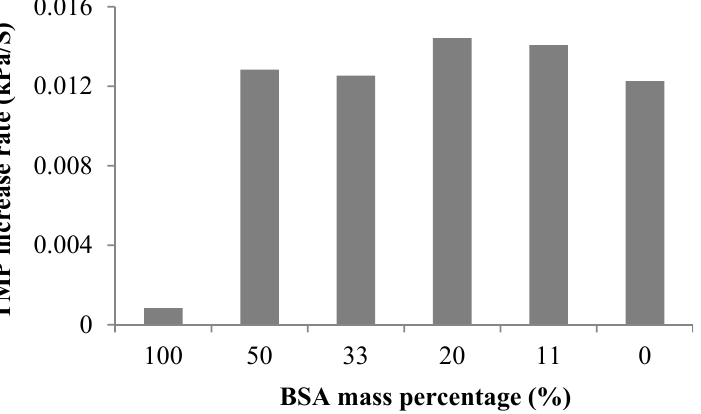
Figure 6. Effect of protein addition on TMP